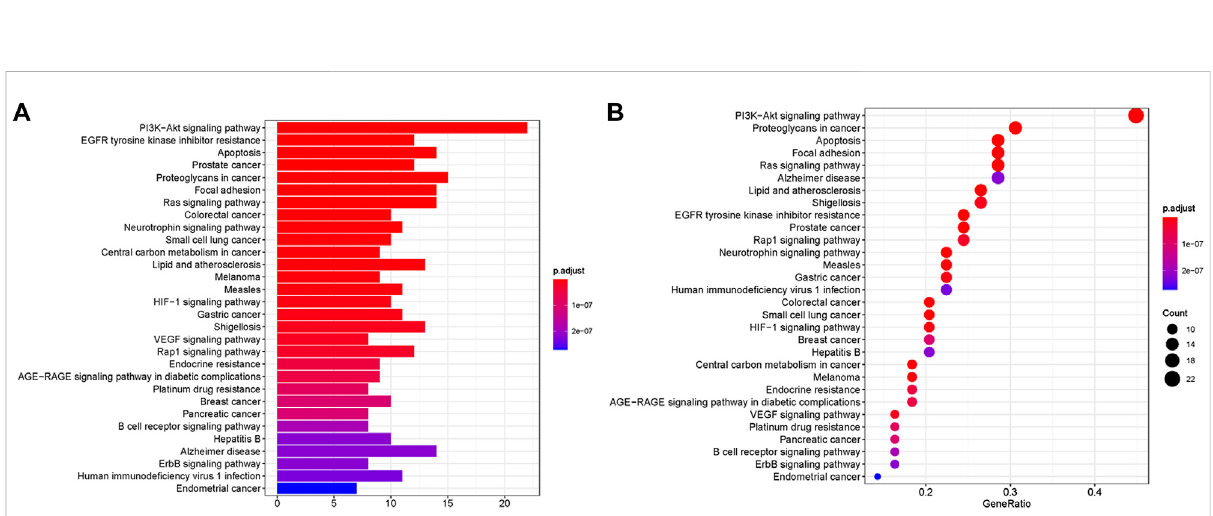
FIGURE 4 KEGG enrichment analyses of targets represented in bar chart (A) and bubble diagram (B) . The bubble size represents the number of genes enriched passage; the larger the bubble, the more enriched the genes. Bubble colors represent signi fi cant enrichment; the redder the color, the higher the degree of